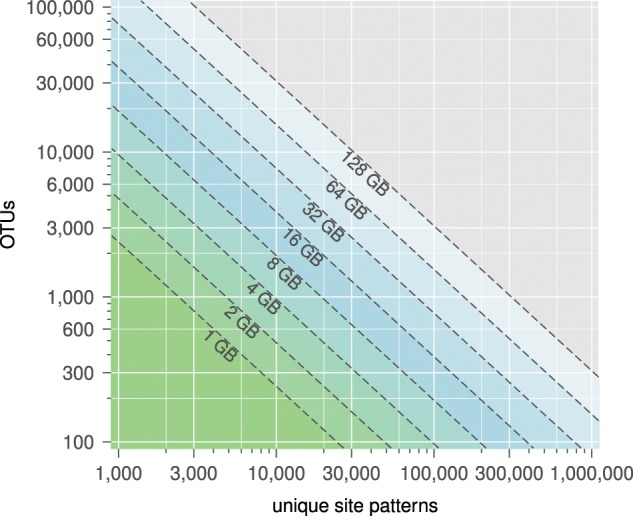
Log–log contour plot depicting BEAGLE-GPU memory usage for BEAST and MrBayes nucleotide-model analyses with four rate categories and double precision floating-point arithmetic, over a range of problem sizes in terms of number of OTUs and of unique site patterns. The amount of memory depicted as values below the dashed isolines convey the upper boundary for the memory size indicated.